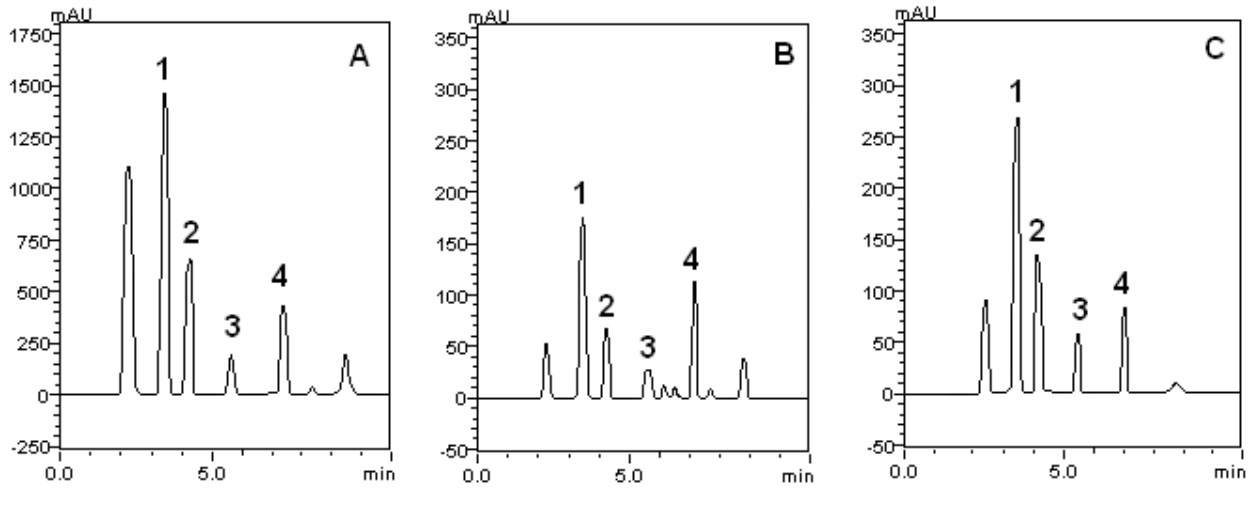
Table 1. Phenolics and flavonoids composition of S. rotundifolium .